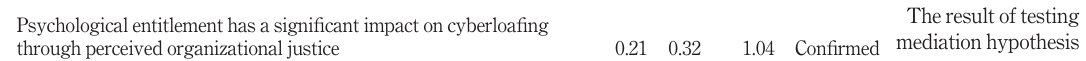
Table 6. The result of testing